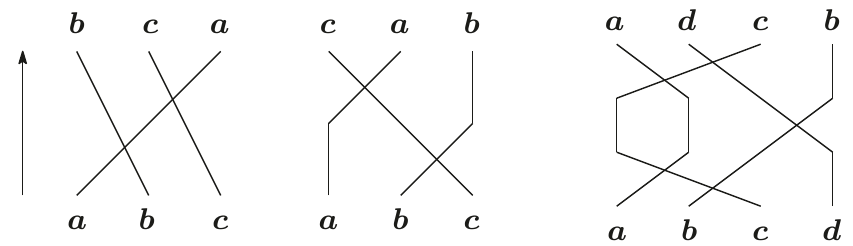
Figure 2 . Permutations represented as diagrams. Left (cid:12)gure shows (123) 2 S 3 , Middle (cid:12)gure shows (12)(23) = (132), and Right (cid:12)gure shows (123)(34)(132) =